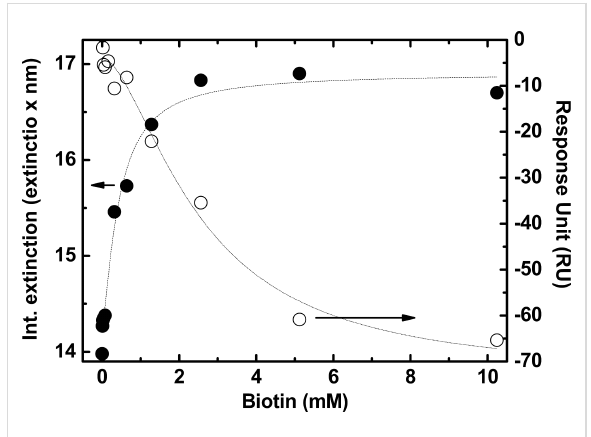
Figure 8: BiotinDNA displacement from AuNP-SA-BiotinDNA ( ● ) and SA-BiotinDNA immobilized on SPR gold sensor chip ( ○ ) by free-biotin represented by the integrated extinction obtained from spectra shown in Figure 4A (left axis) and by SPR data shown in Figure 6C (right axis),